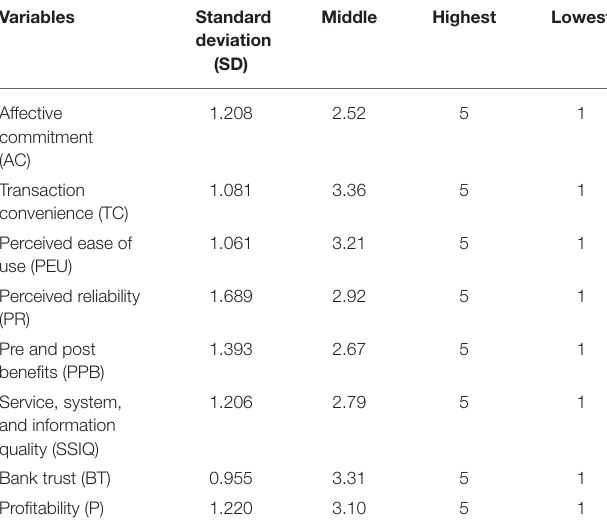
TABLE 6 | Descriptive data